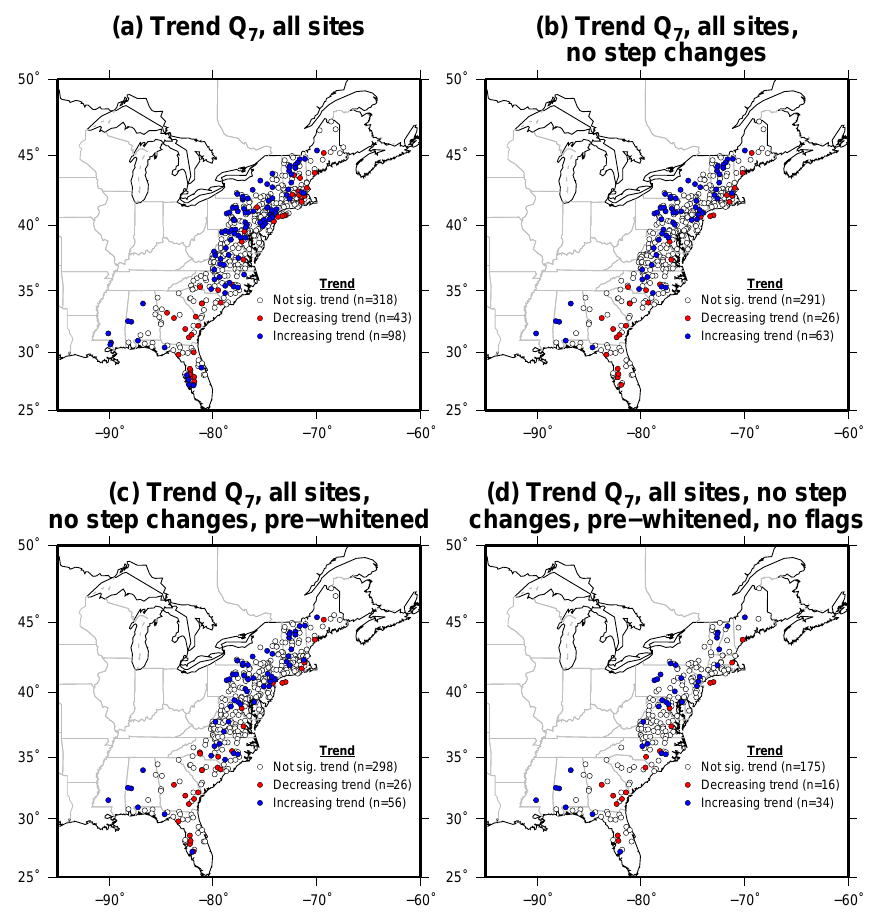
Figure 7. Trends in Q7 for 1951–2005 for (a) all sites, (b) excluding sites with step changes or overall autocorrelation, (c) as (b) but with pre-whitened data, and (d) as (b) but without USGS